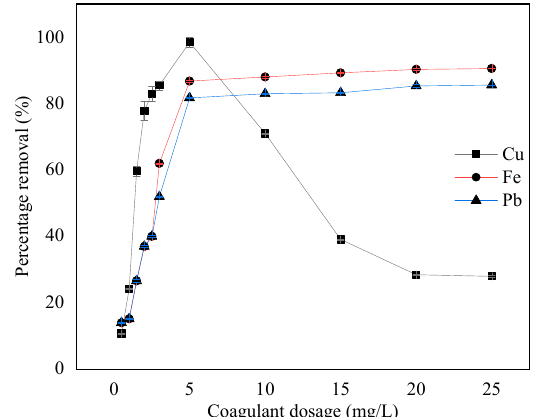
Figure 7. Effects of MCNC dosage on Cu/Pb/Fe removal from aqueous solution (initial concentration of (Cu/Pb/Fe): 20 mg/L, pH: 7.20, volume: 500 mL.